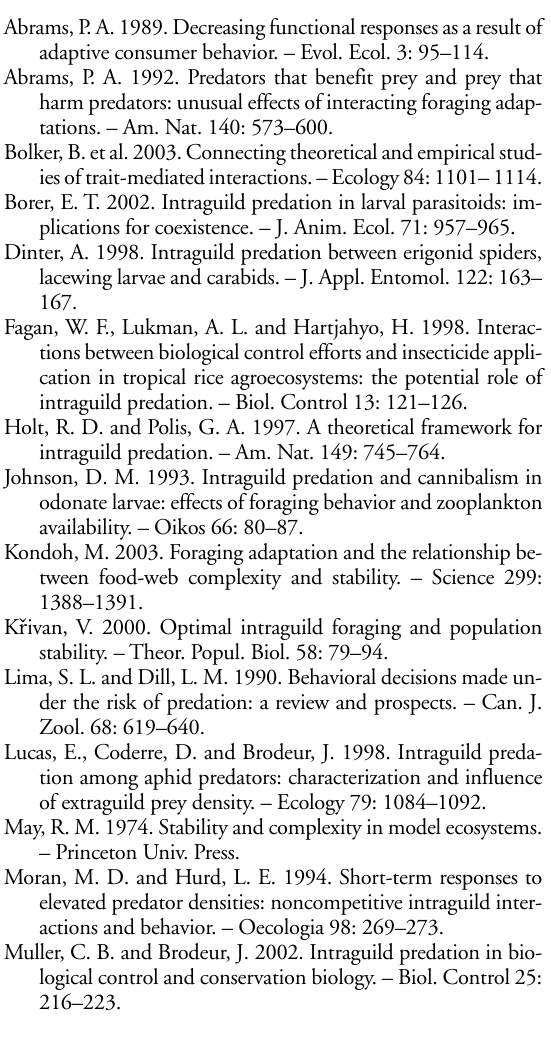
, b ) that results in commu- P N = 1, A = 1, m = 0.5, m = N P N P